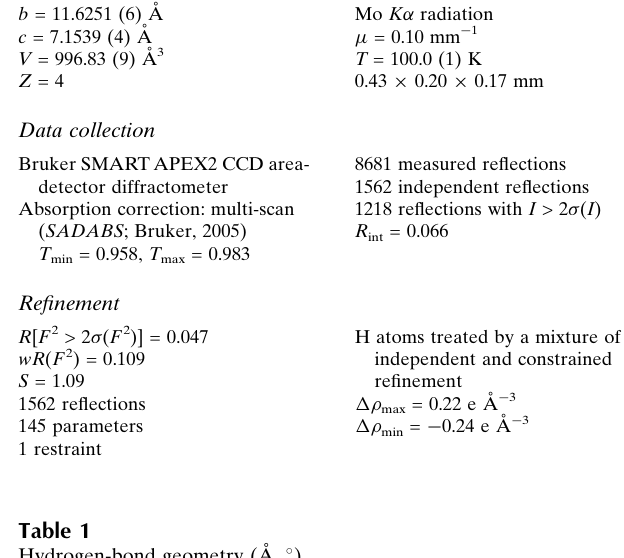
Hydrogen-bond geometry (A˚ , (cid:4) ). Cg 1 is the centroid of the C5–C10